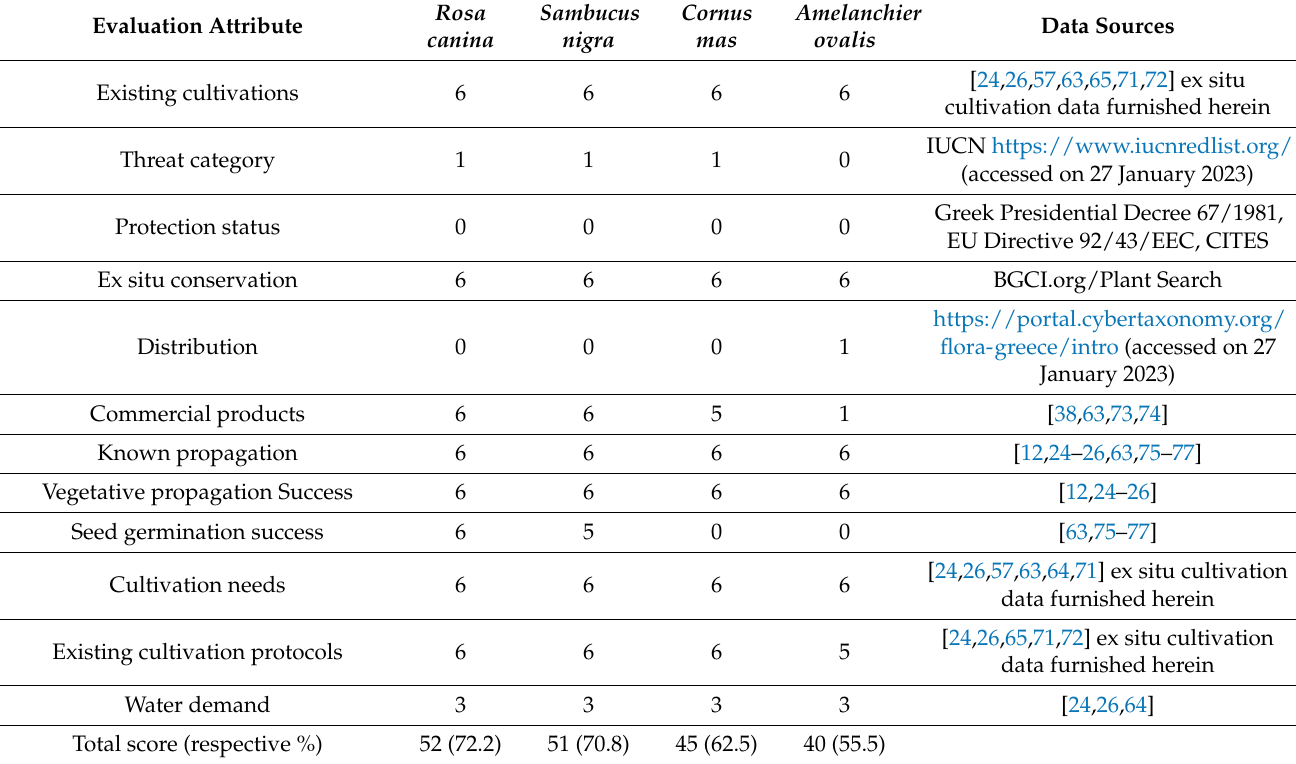
Table 1. Overview of the individual scores against 12 attributes designated by Krigas et al. [14], the overall score achieved per species out of a maximum total score of 72, and respective feasibility percentage (%) along with the literature sources used in the evaluation of feasibility for sustainable exploitation regarding the four focal species studied herein ( Amelanchier ovalis , Cornus mas , Rosa canina , and Sambucus nigra